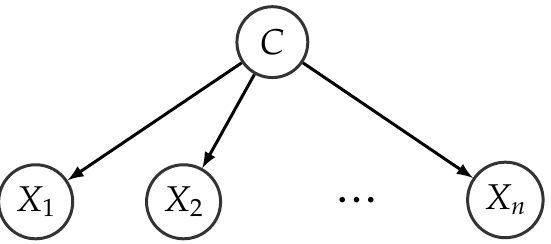
Figure 2. Naive Bayes structure. Feature variables X 1 , . . . , X n are independent given the value of the class variable C